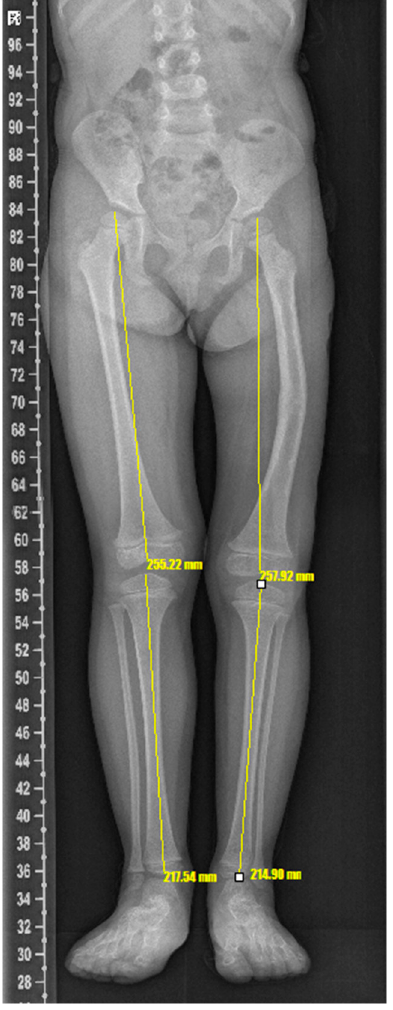
Figure 5. Post-operative scanogram demonstrating reduced leg length discrepancy.